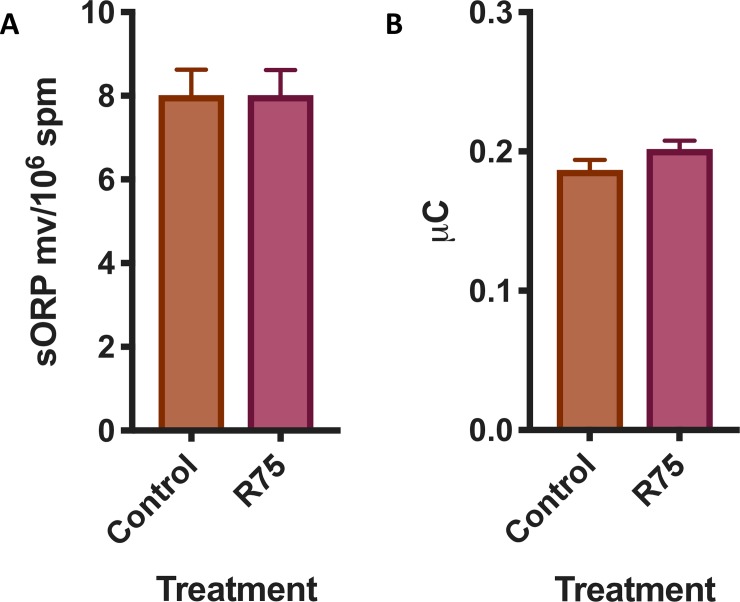
Effect of rosiglitazone added to the thawing media on sORP (mV/106 sperm) (A) that is the integrated measure of the existing balance between oxidants and reductants and (B) antioxidant capacity reserve cORP (μC) (results are derived from three independent frozen ejaculates from 6 different stallions n = 18).